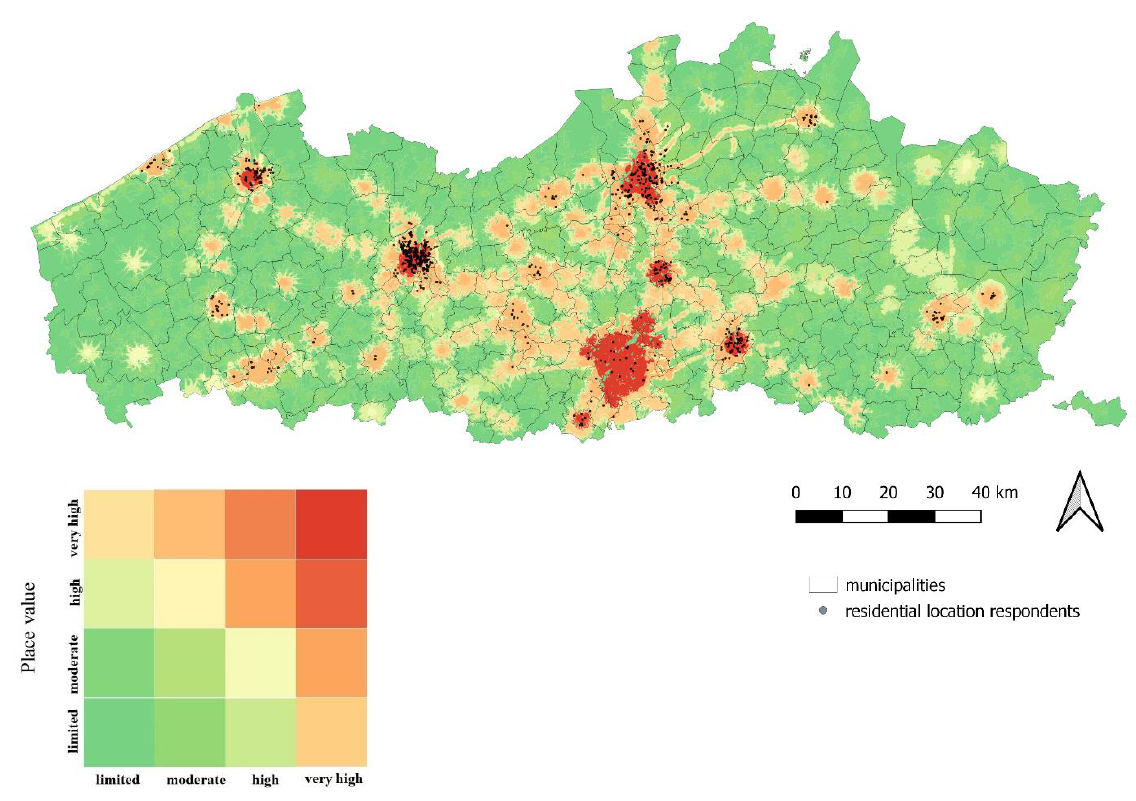
Figure 2: Residential location of survey respondents. Background: synthesis of node-place value (Verachtert et al.